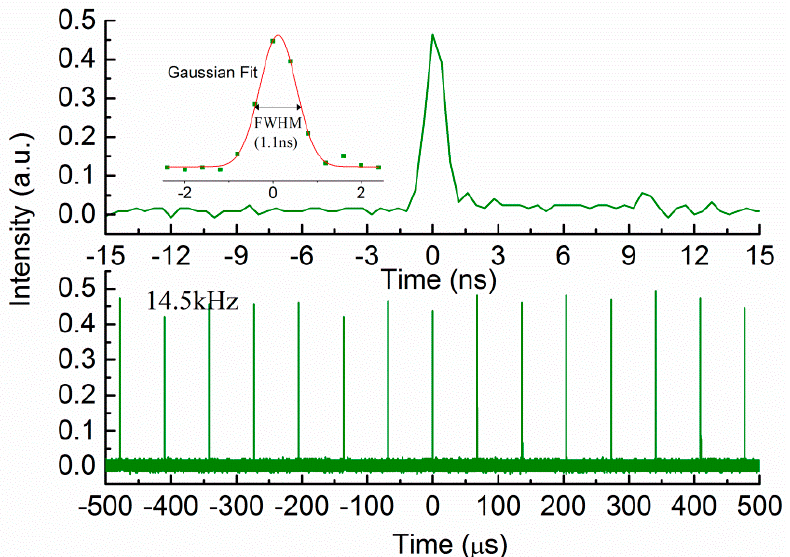
Figure 6. Temporal pulse profiles and pulse trains under the incident pump power of 10.5 W.